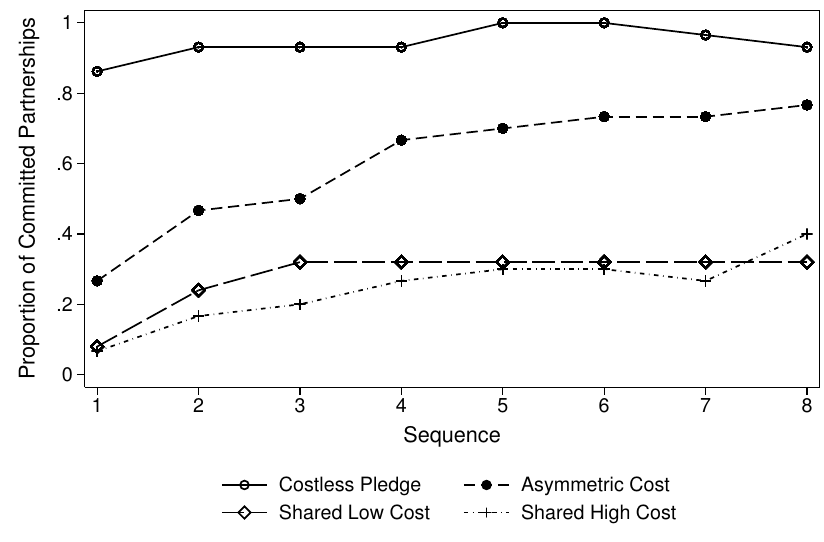
Figure 4. Proportion of committed partnerships by